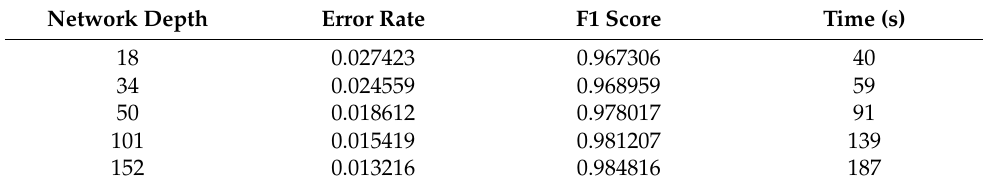
Table 6. Network depth on validation split = 50.